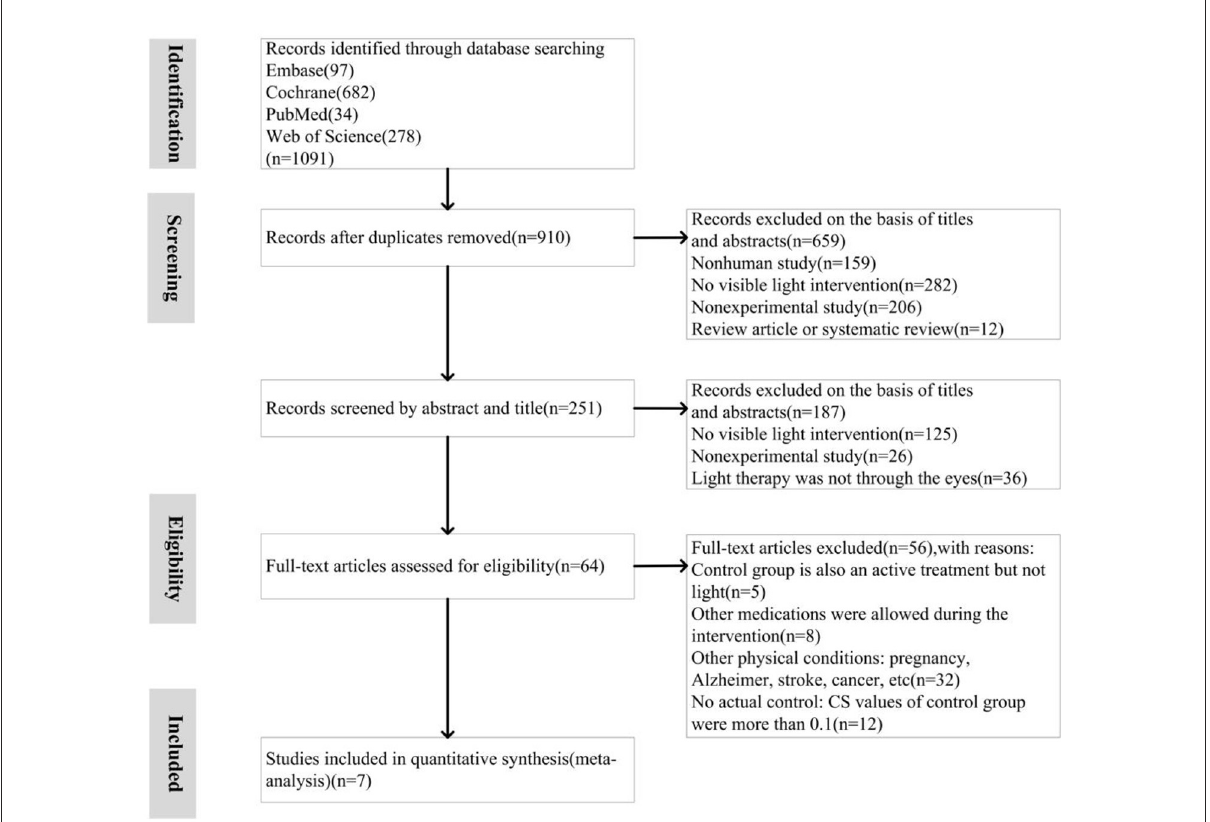
FIGURE2 Risk-of-bias graph: Shown are the judgments about each risk-of-bias item, presented as percentages of all included studies.